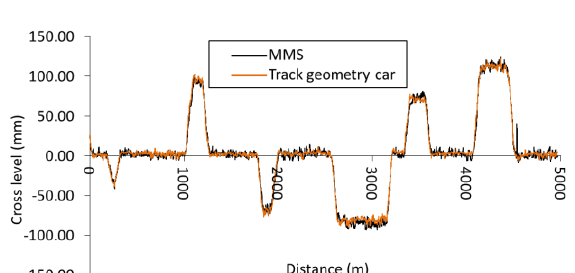
Figure 11. Comparing calculated gauge and measured one